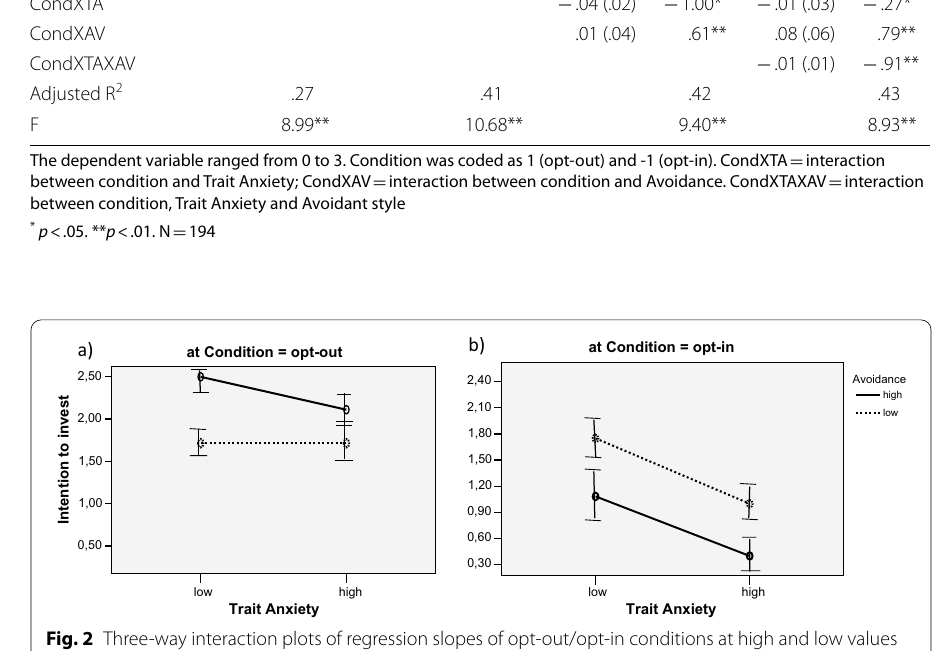
interaction between condition and Avoidance. CondXTAXAV =